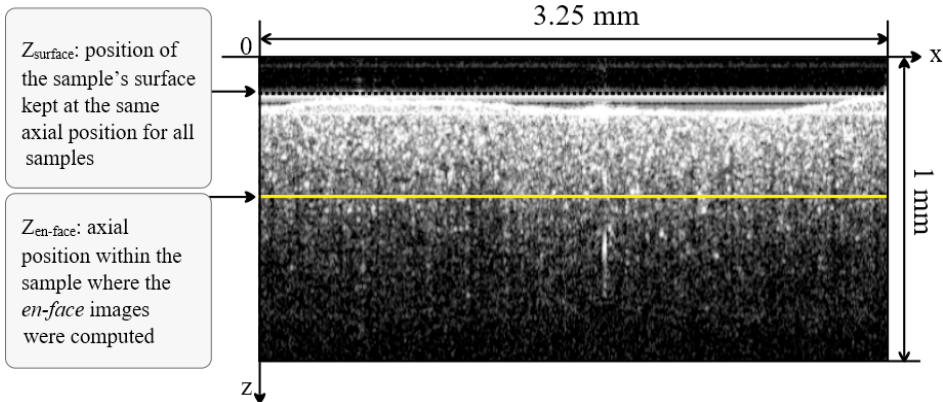
Figure 3. Example of an OCT B-scan/cross-section to show the method of selection of the depth from where the en-face images were selected. For all of the samples, their outer surface at z surface was adjusted with respect to OPD = 0, to produce all of the en-face OCT images (for all samples) from a similar depth ( z en-face ).